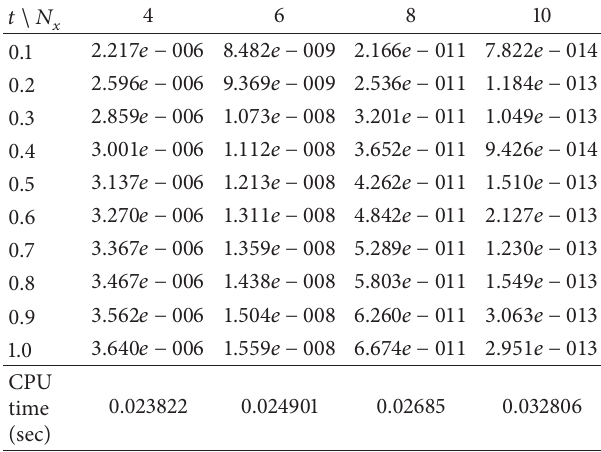
Table 6: Maximum errors 𝐸 𝑁 for the highly nonlinear modified KdV equation, with 𝑁 𝑡 = 10